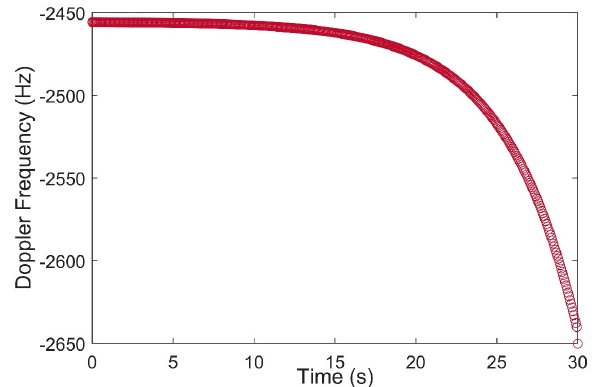
( b ) Figure 11. Doppler points for two Iridium satellites using ( a ) Ring alert bursts and ( b ) Quaternary message bursts. The proposed EKF-based Doppler positioning method was implemented and tested in MATLAB, using the obtained Doppler shift measurements of the designed multi-constellation software-defined receiver. The Doppler measurements of one Orbcomm satellite and two Iridium- Next satellites were injected into the positioning system. The experiment was performed one time using Ring alert, and the other time using Quaternary message bursts. Moreover, the positioning result is compared to a single constellation mode. Figure 12 demonstrates the estimated and true reference position for a stationary receiver.